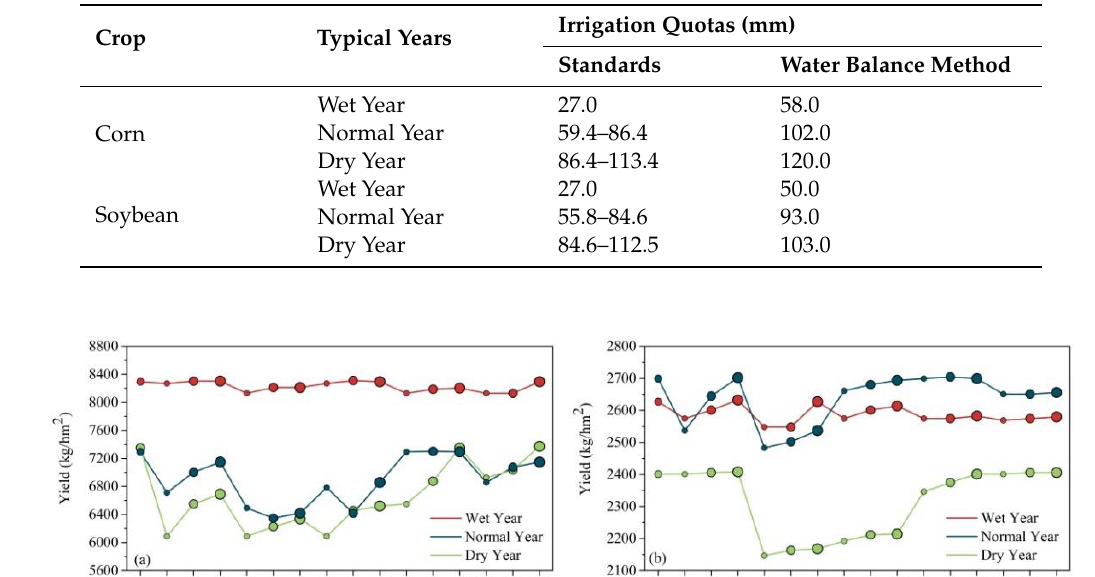
Table 4. Crop irrigation quotas standards.